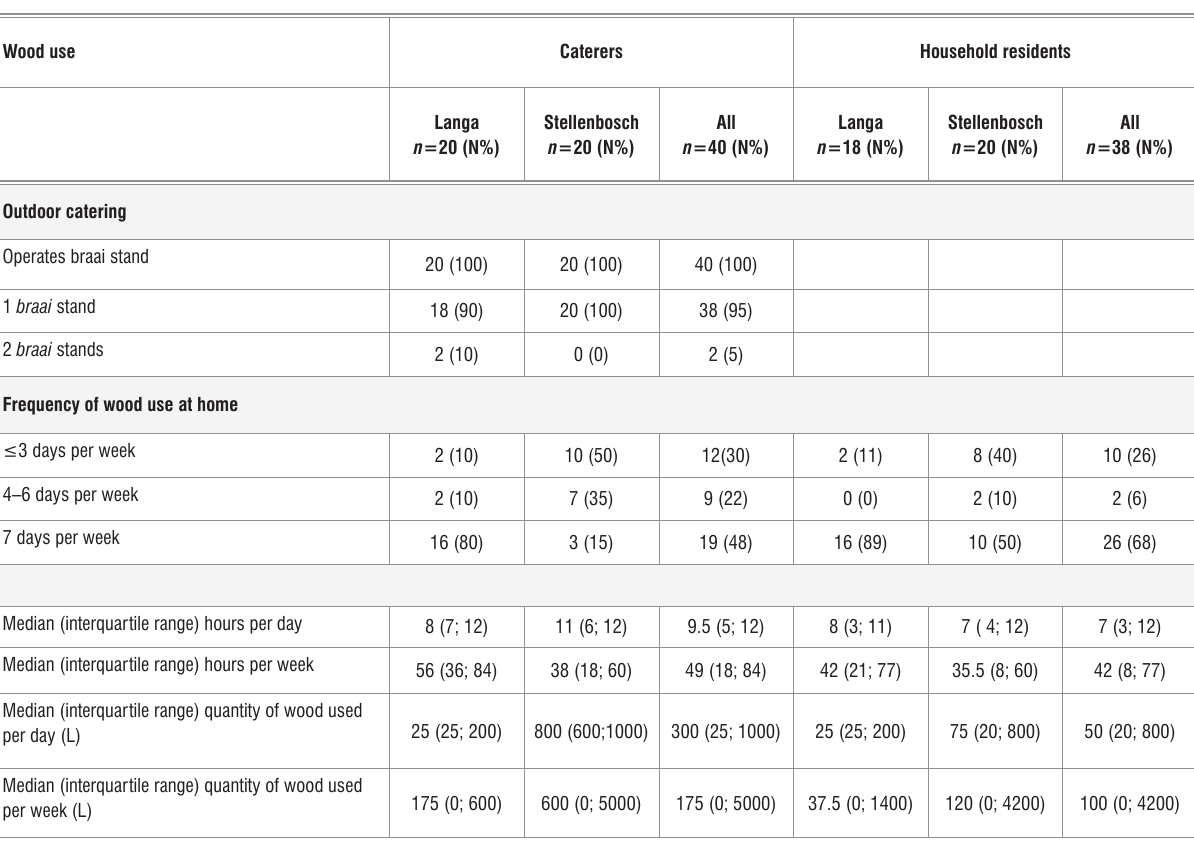
Table 3: Wood usage amongst caterers and household